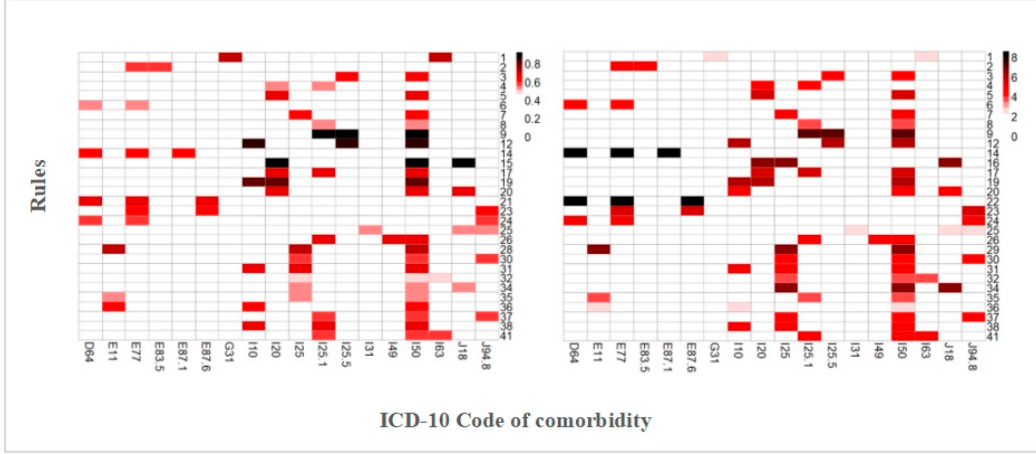
Figure 6. Heatmaps for the confidence and lift values observed in the 41 derived association rules. ( a ) The rows are for rules, and the columns are for XX morbidities. ( b ) Defined similar to ( a ).